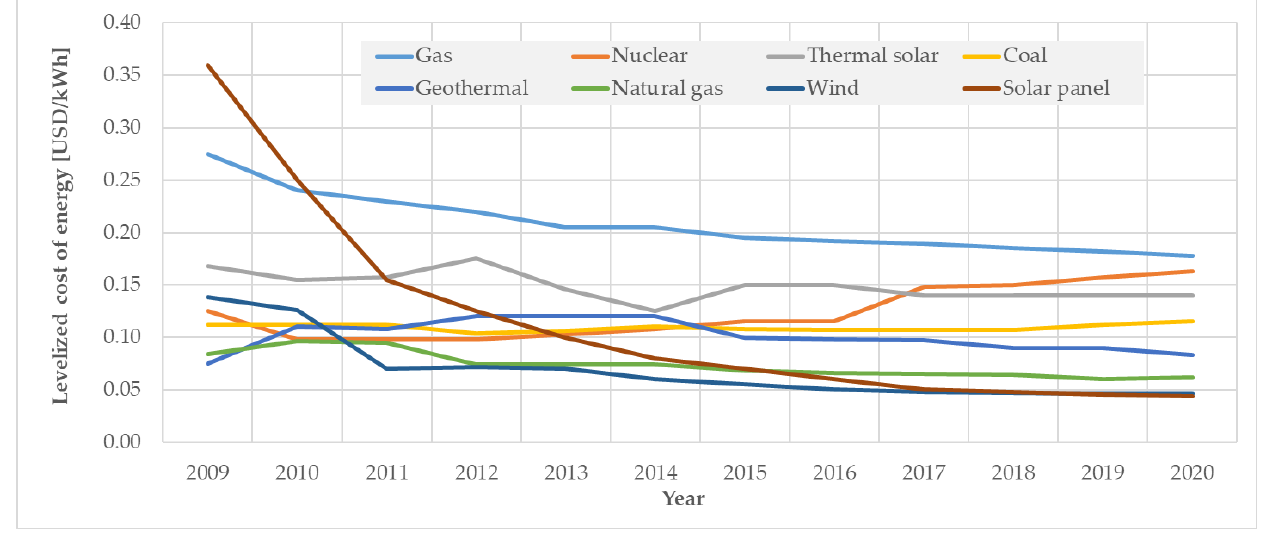
Figure 7. Levelized cost of energy depending on the electricity generation source in USD/kWh [68].